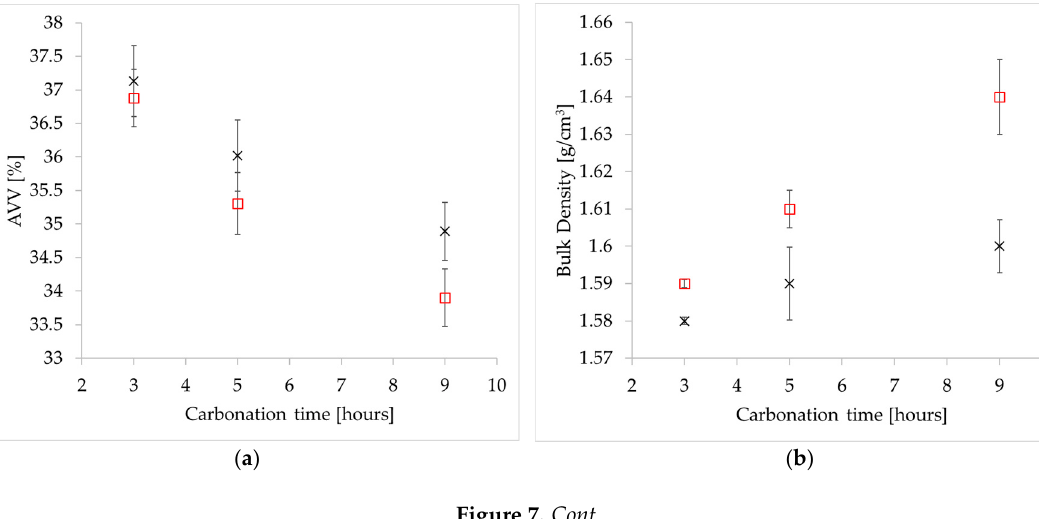
Figure 6. Average values of mechanical properties at different CO 2 pressures (× 1 and □ 3 bar CO 2 pressure): ( a ) Modulus of rupture (MOR); ( b ) modulus of elasticity (MOE) and ( c ) toughness.